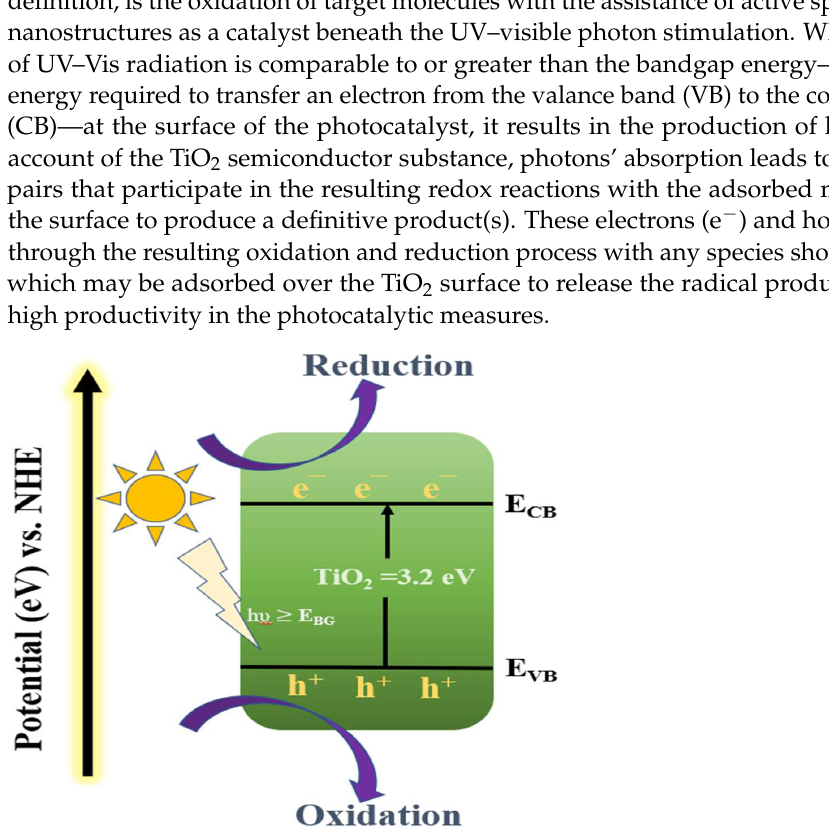
Figure 3. Schematic illustration of the reaction mechanism for a photon-induced reaction process in a TiO 2 semiconductor.